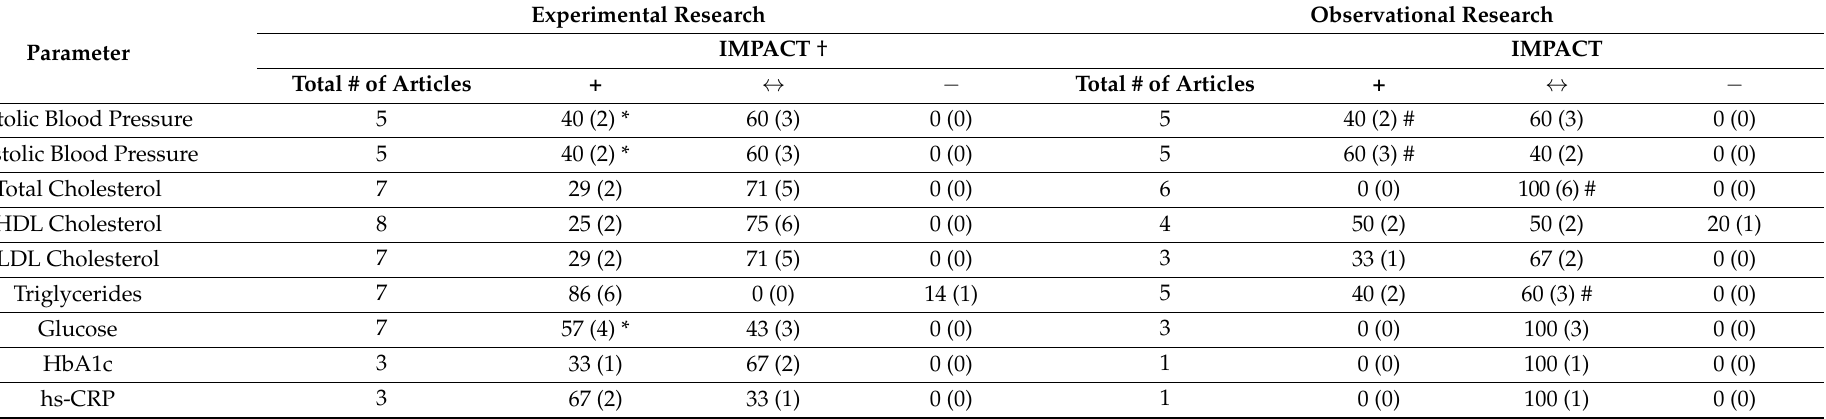
Table 4. Summary of experimental and observational studies reporting on primary